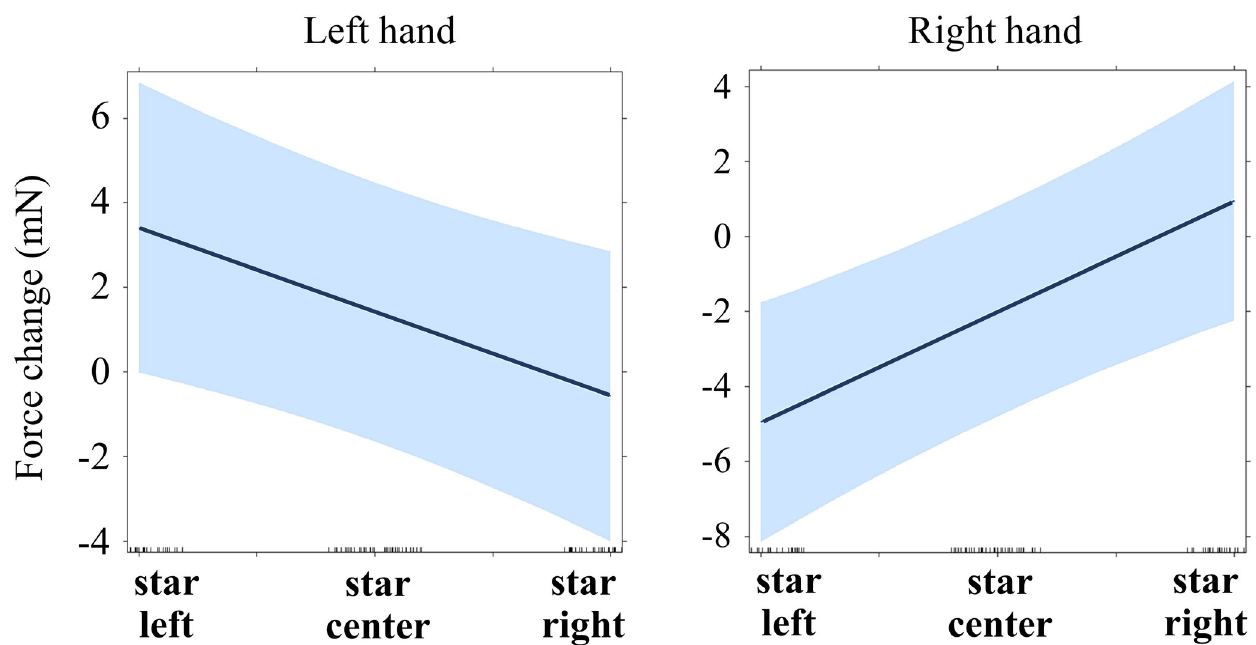
Fig 5. Regression lines for the main effect of star position on force (Experiment 1, time window 260–1000 ms). See main text for details (Models 1.5 and 1.6).